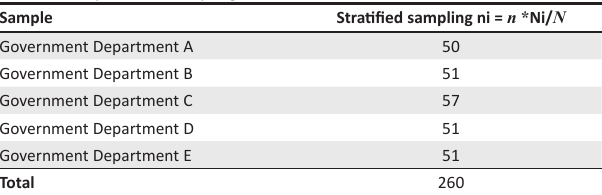
TABLE 1: Proportional sampling. Sample Stratified sampling ni = n * Ni/